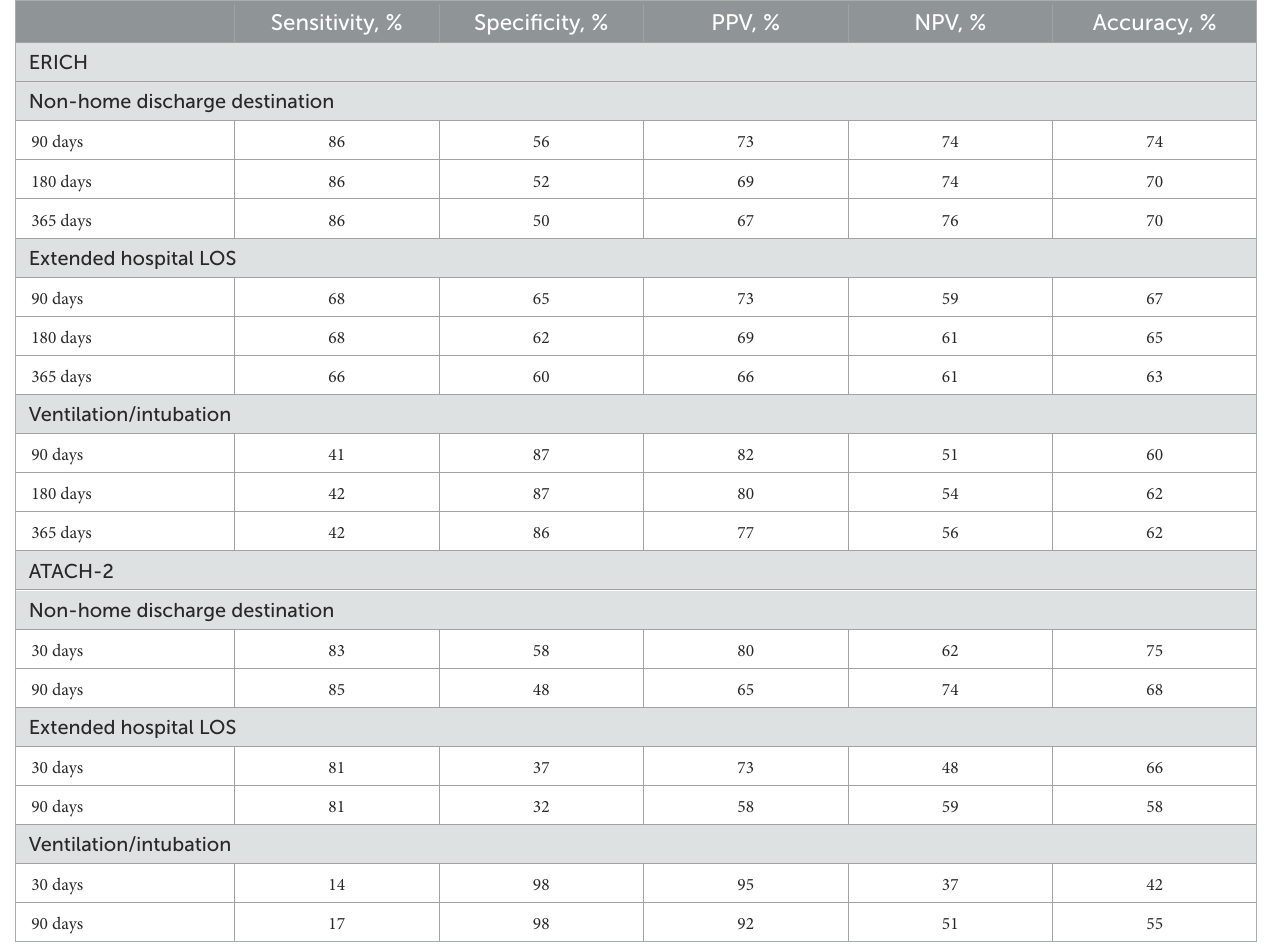
TABLE 3 Discriminative ability of proxy measures for unfavorable functional outcome (mRS Score 3–6) in ERICH and ATACH-2. Sensitivity, % Specificity, % PPV, % NPV, % Accuracy, %